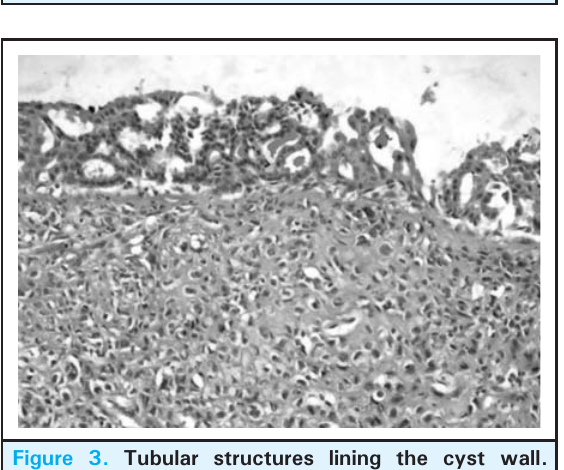
Figure 3. Tubular structures lining the cyst wall. Sheets of tumor cells are seen underneath cyst wall. (HE stain x100)